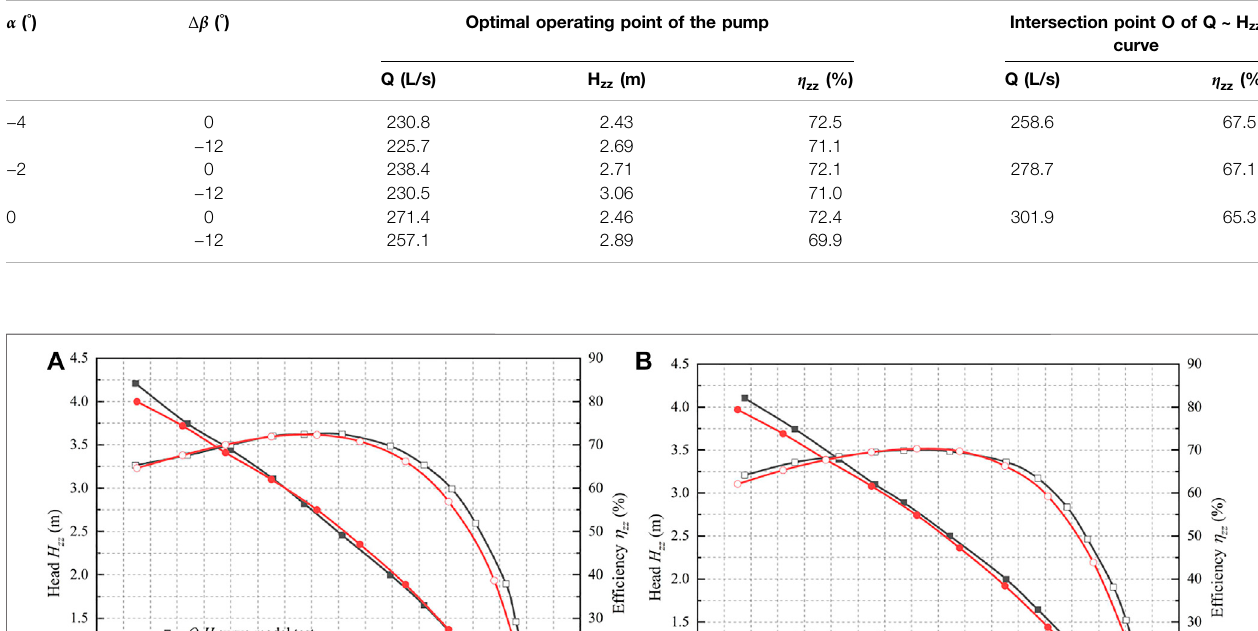
Frontiers in Energy Research |